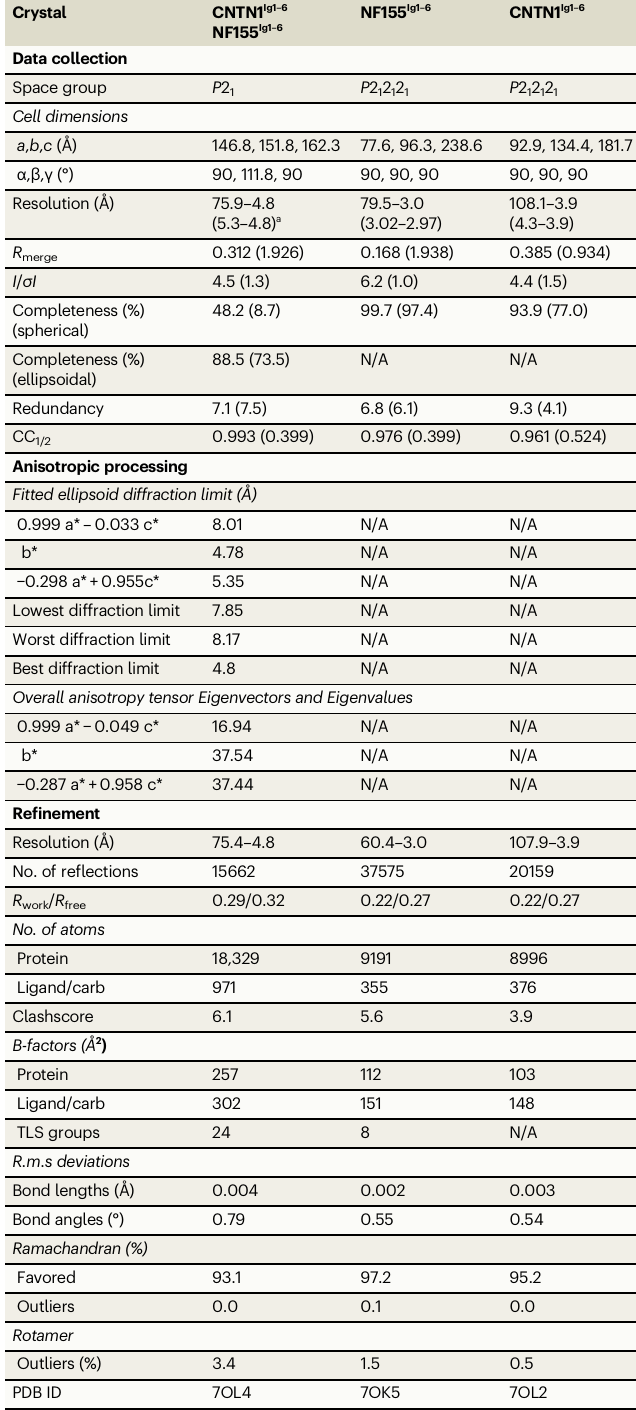
Table 1 | X-ray diffraction data collection and re fi nement